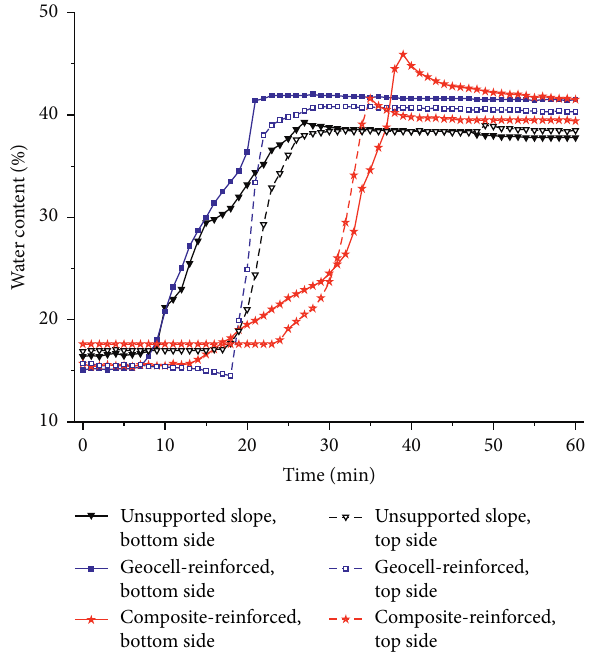
Figure 10: Variation of water content in the slope soil during